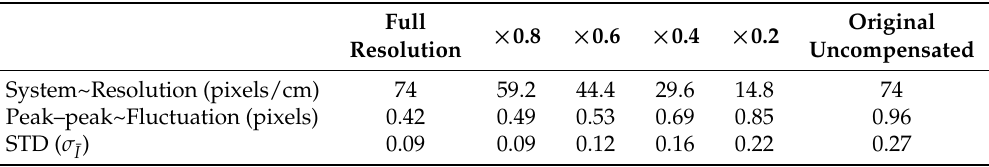
Figure 11. ( a ) Effect of system resolution on the image registration results along the X -axis and ( b ) on the spatially averaged signal extracted from ROI using the Intensity 1 scheme. Both the width and height were progressively reduced from a full-scale × 1.0 down to × 0.2. Table 2. Results of peak–peak fluctuation and standard deviation before and after image registration obtained by simulating a range of system resolutions (pixels/cm of skin) for a prosthetic silicone